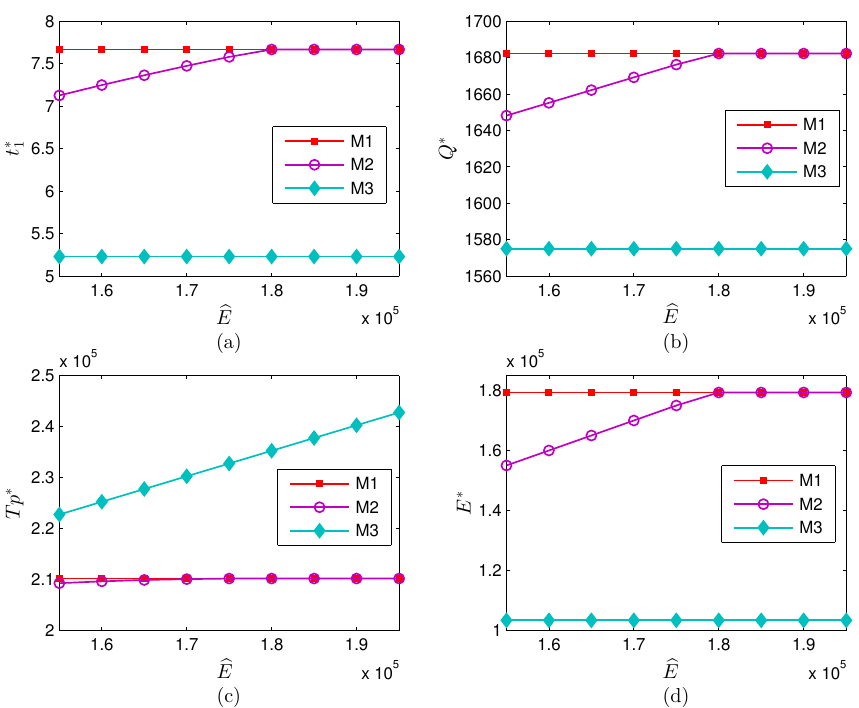
Figure 4. The impacts of carbon cap on the optimal inventory performance. ( a ) Comparison of the optimal time point with carbon cap. ( b ) Comparison of the optimal order quantity with carbon cap. ( c ) Comparison of the optimal total profit with carbon cap. ( d ) Comparison of the optimal total carbon emissions with carbon